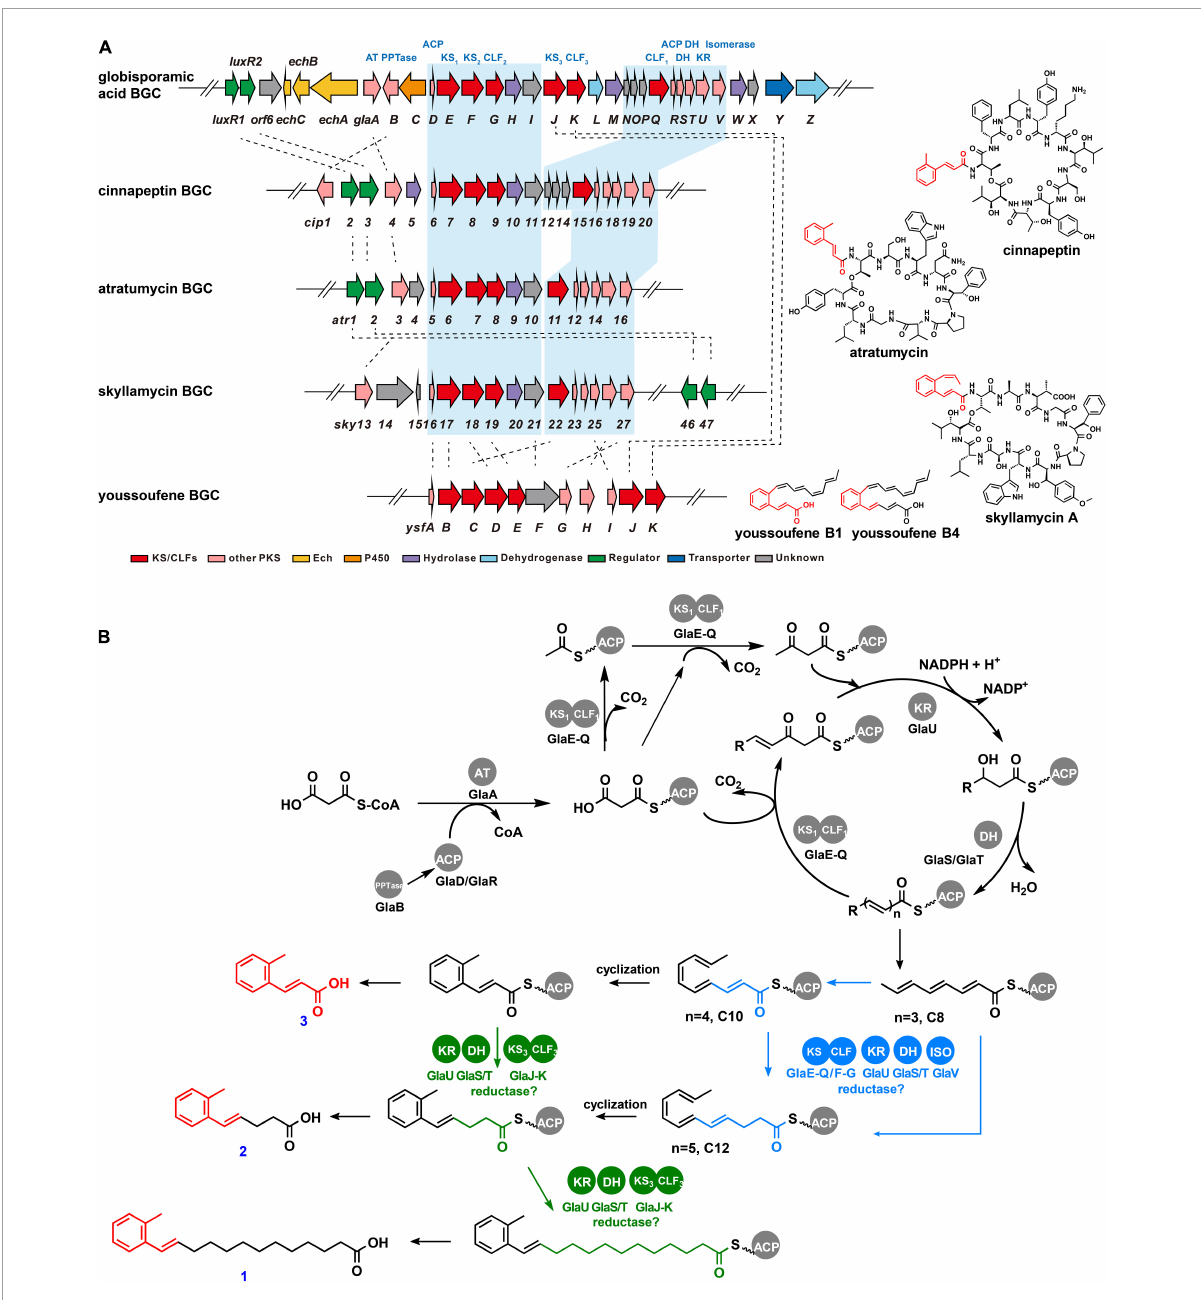
FIGURE3 Gene cluster mining and proposed biosynthetic pathway of globisporamic acid. (A) Genetic organizations of the BGCs of globisporamic acid and cinnamoyl moiety-containing compounds. The blue-shaded region represented the amino acid sequence alignment of PKS genes with their homologs. The chemical structure of the natural products from the corresponding BGCs was shown on the right. (B) Proposed biosynthetic process of globisporamic acid. The pathway putatively catalyzed by KS 1 -CLF 1 (GlaE-GlaQ) or KS 2 -CLF 2 (GlaF-GlaG) was highlighted in blue, while that catalyzed by KS 3 -CLF 3 (GlaJ-GlaK) was highlighted in green.